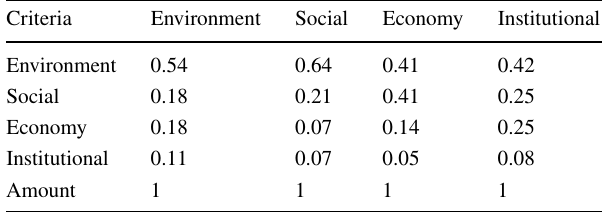
Table 3 Normalization pairwise comparison matrix Criteria